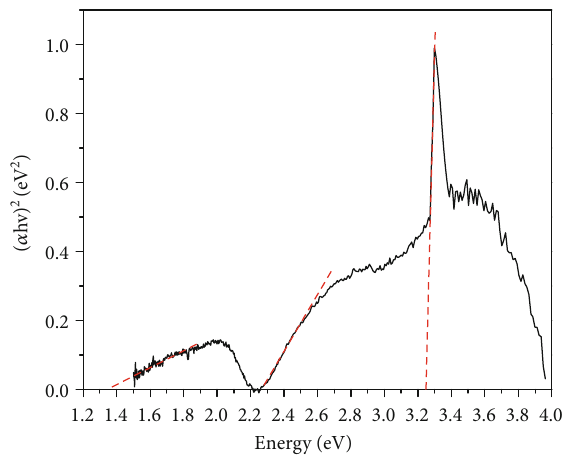
Figure 4: XRD di ff ractograms of (a) MTF and (c) TMTF after annealed to 450 ° C.